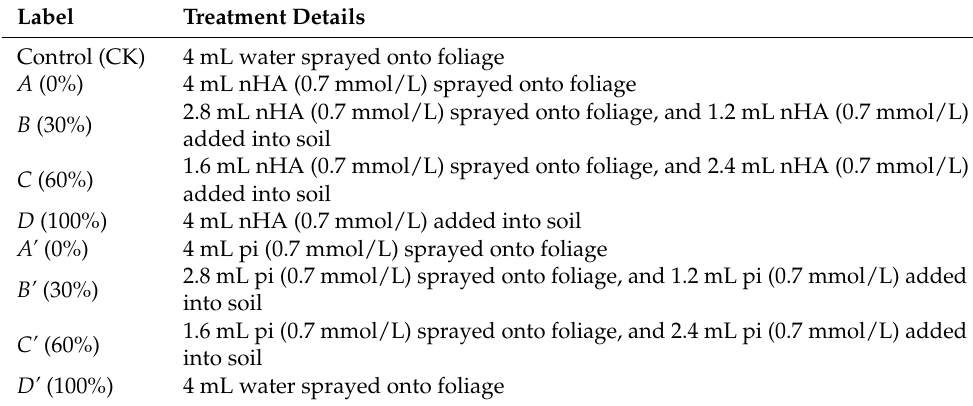
Table 1. Details of each treatment in the simulated precipitation